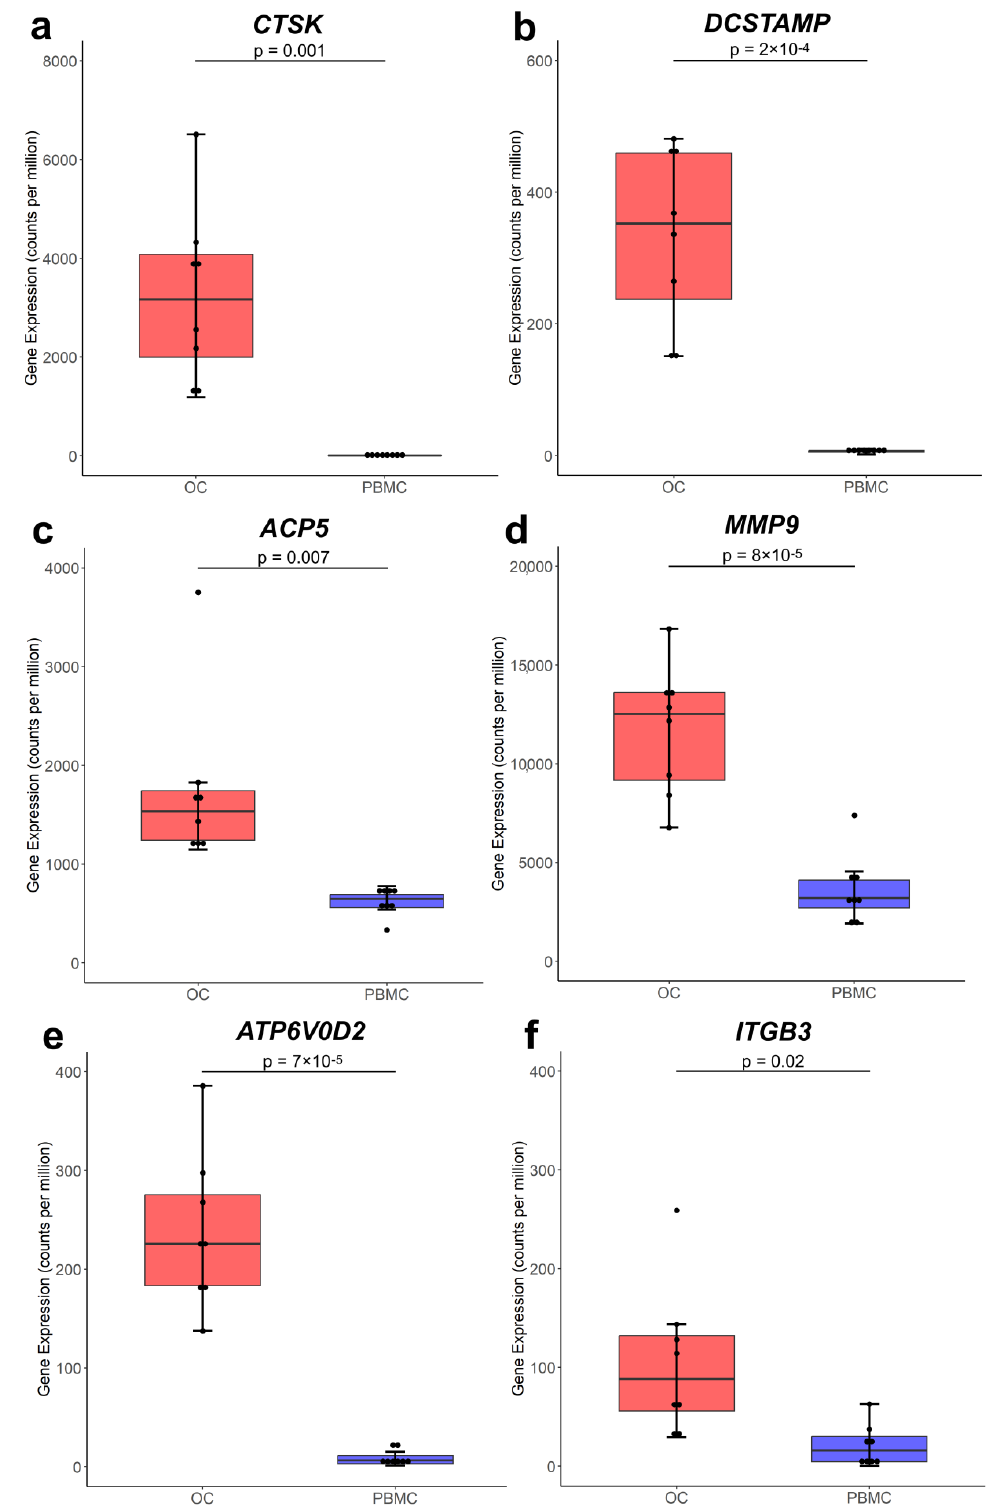
Figure 2. Box plots displaying the relative expression of established OC genes: ( a ) CTSK , ( b ) DC- STAMP , ( c ) ACP5 , ( d ) MMP9 , ( e ) ATP6V0D2 , ( f ) ITGB3 . The box plots are filled in red (left) and blue (right) representing the OC and PBMC groups, respectively. The y-axis indicates the expression of the genes in counts per million, whereas the x-axis denotes the OC and PBMC groups. A solid horizontal line in the middle of each box plot represents the median gene expression value. p -values in these plots were calculated using a t -test, with p < 0.05 considered statistically